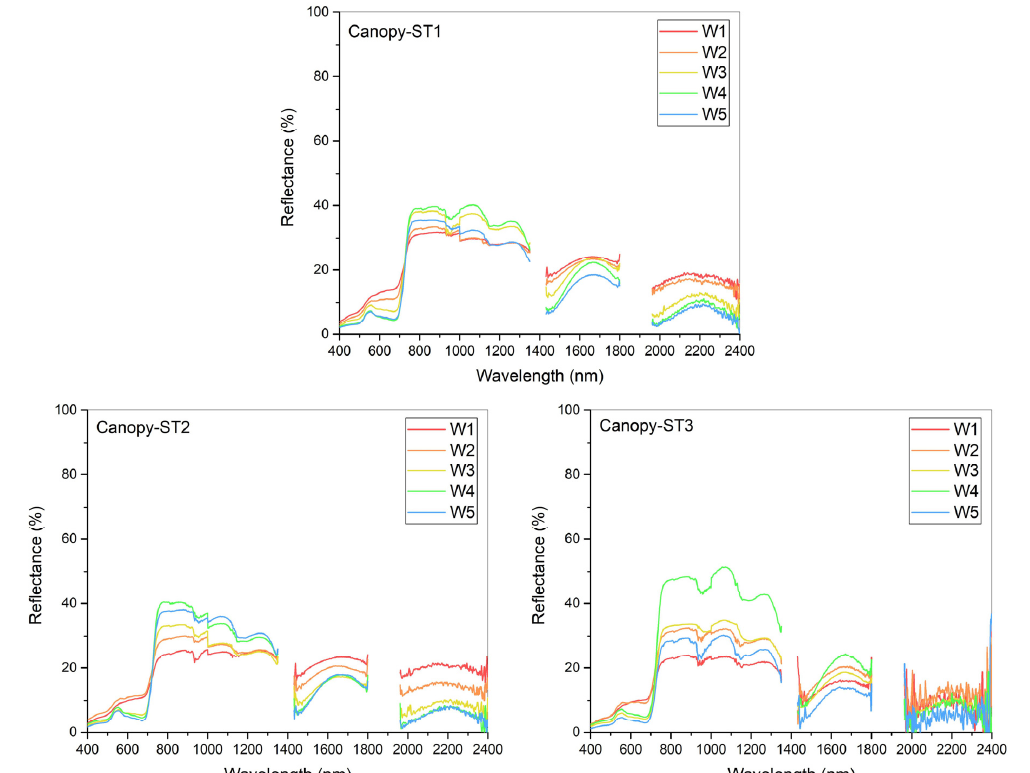
Figure 4. Canopy spectral characteristics of summer maize at different growth stages under continuous water stresses.